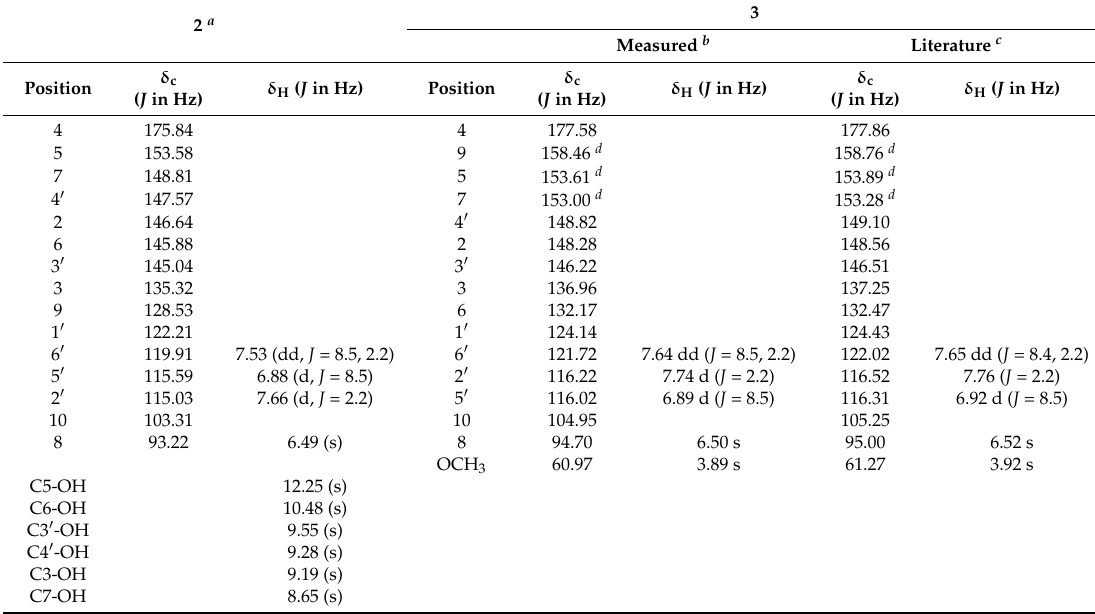
Figure 3. HMBC correlations of quercetagetin. Table 1. 1 H and 13 C-NMR data of quercetagetin ( 2 ) and patuletin ( 3 ) (ppm).